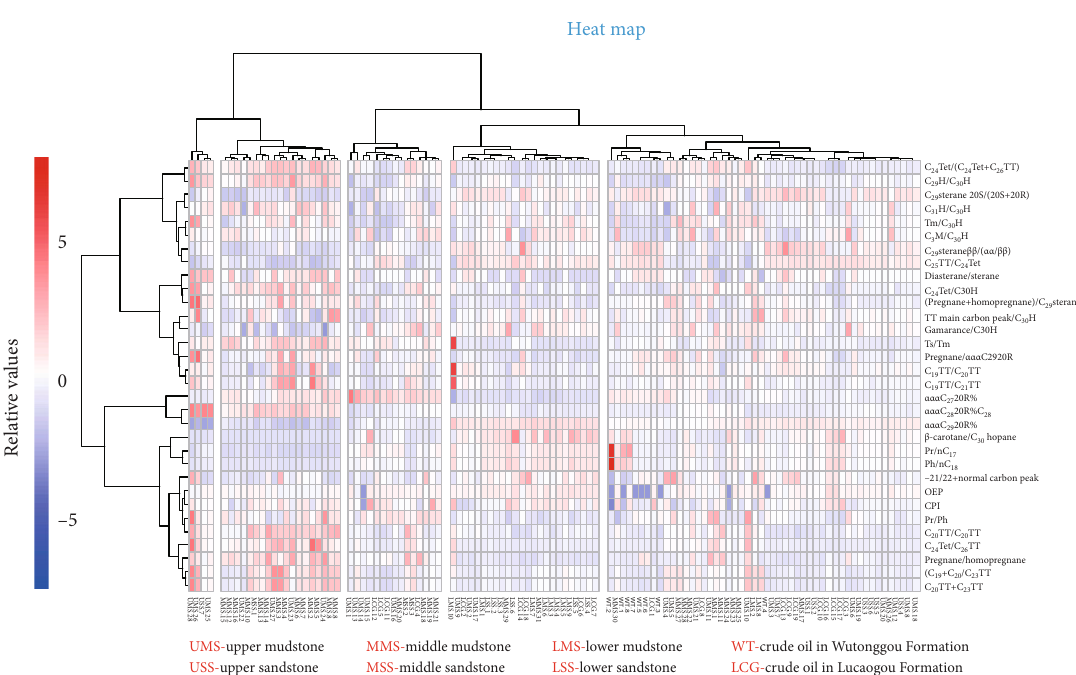
Figure 4: Clustering heat maps of 32 indicators from all 112 samples. The Bray – Curtis algorithm was used to conduct the